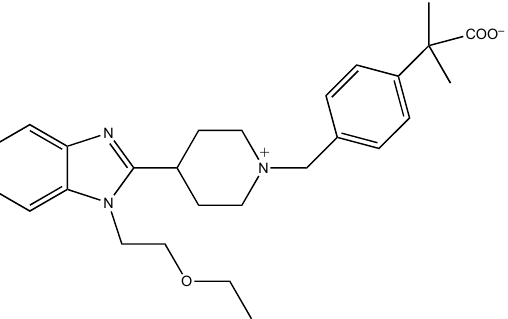
Figure 1. Chemical structure of bilastine. Bilastine is a zwitterionic second-generation antihista- mine containing a carboxyl group that contributes to its non-sedative properties as well as an in- creased selectivity for H 1 receptors.